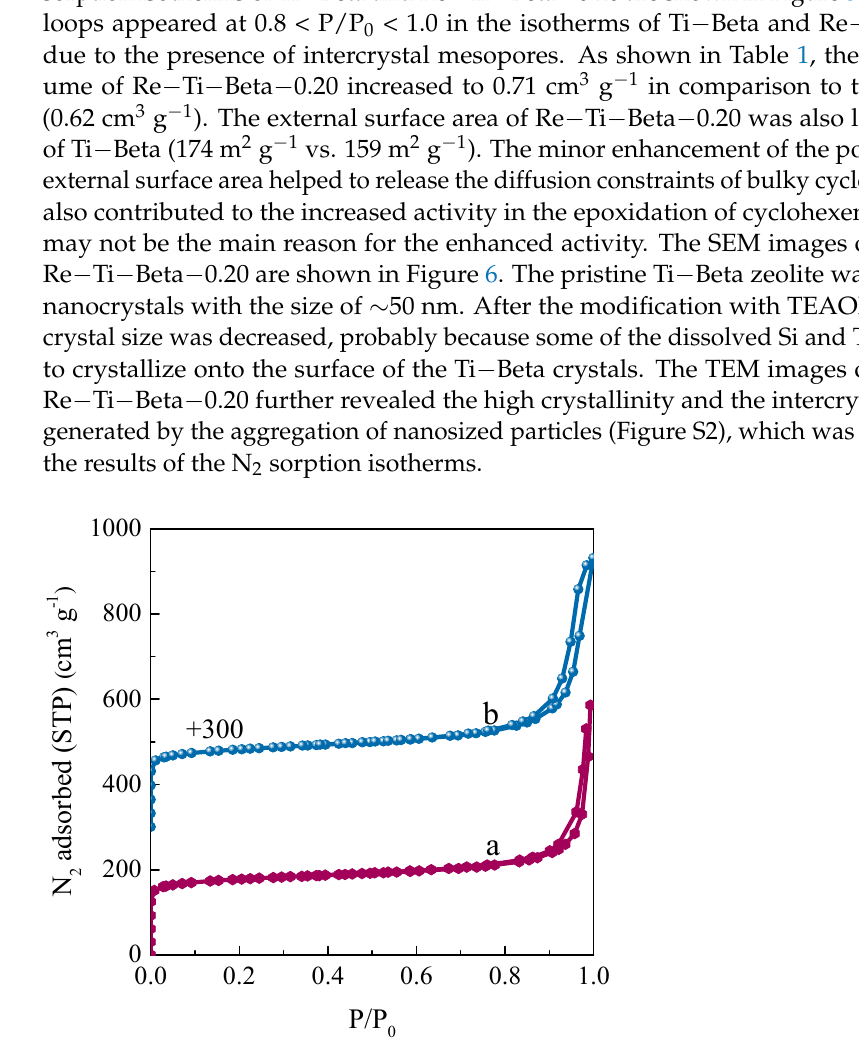
Figure 5. N 2 adsorption − desorption isotherms at 77 K of Ti − Beta (a) and Re − Ti − Beta − 0.20